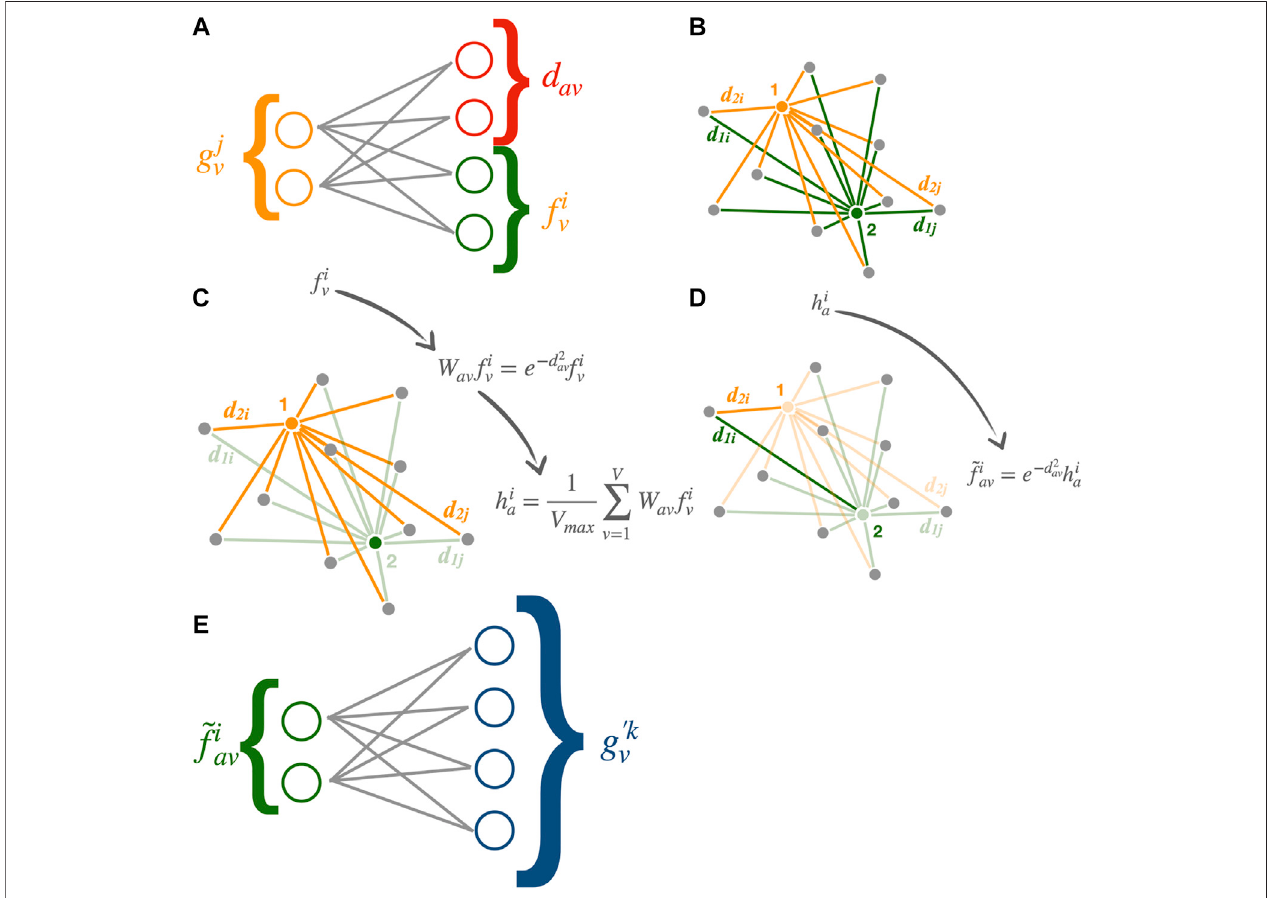
FIGURE1| Processing fl owofthemodi fi ed GARNET algorithm: (A) Theinputfeatures ( g j v ) ofeachvertexareprocessedbyalinearnetwork,thatreturnsanewsetof features ( f i v ) and its distance from the S aggregators ( d av ) . (B) A graph is built in the learned space, using the d av distances. (C) A message is gathered by each aggregator,asaweightedsumacrosstheverticesof f i v ,with W av (cid:2) exp (− d 2 av ) asweights. (D) Amessagefromeach aggregator( ~ f i av )ispassedbacktoeachvertex, with the same W av weight. (E) The aggregated outputs of each vertex are given as input to a neural network, which returns the learned representation.